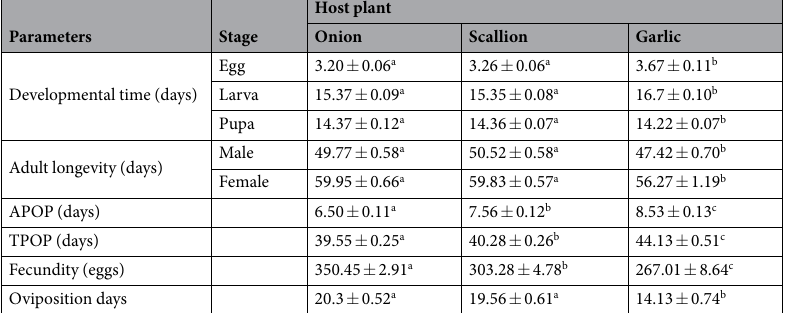
Table 1. Developmental time, adult longevity, fecundity, adult preoviposition period (APOP), total preoviposition period (TPOP), and oviposition days of Delia antiqua on different host plants of Individually reared method. The difference between treatments were evaluated by using paired bootstrap test. Values are means ± standard errors; a,b,c Means in a row followed by different letters are significantly different at p < 0.05 by using paired bootstrap test (Table